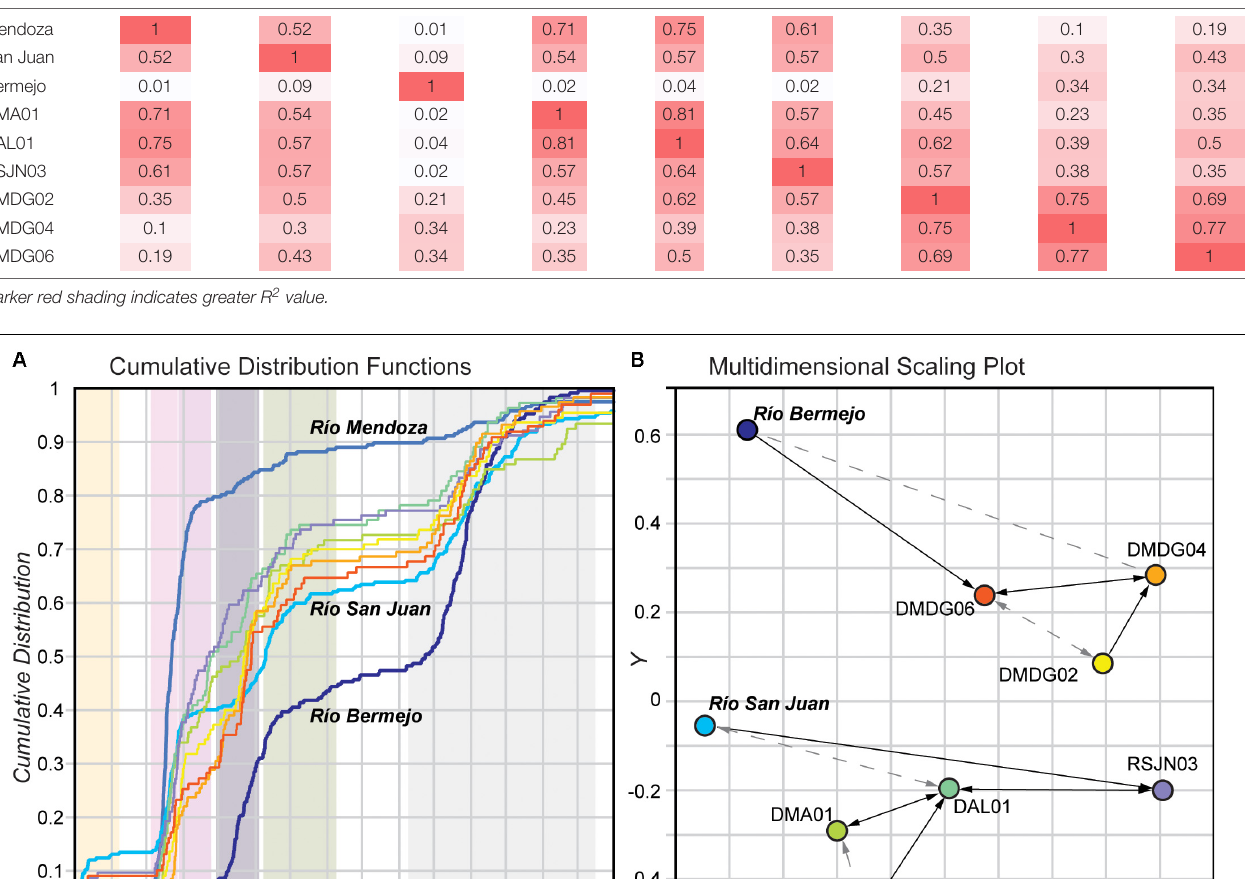
TABLE 1 | Inter sample KDE cross correlation R 2 coefficient results.